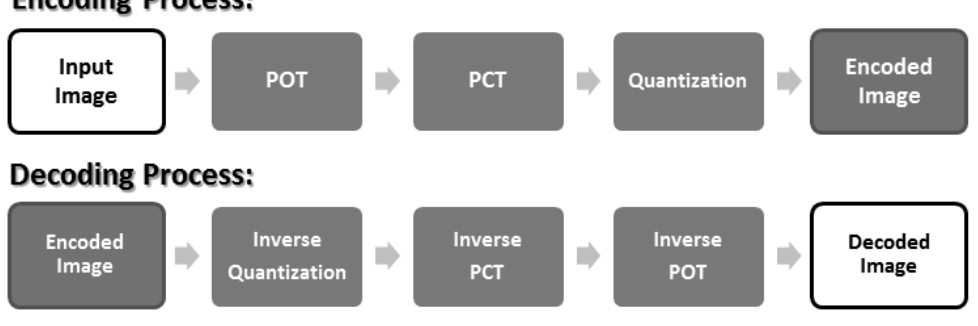
Figure 4. JPEG-XR encoding/decoding process. POT, Photo Overlap Transform; PCT, Photo Core Transform.